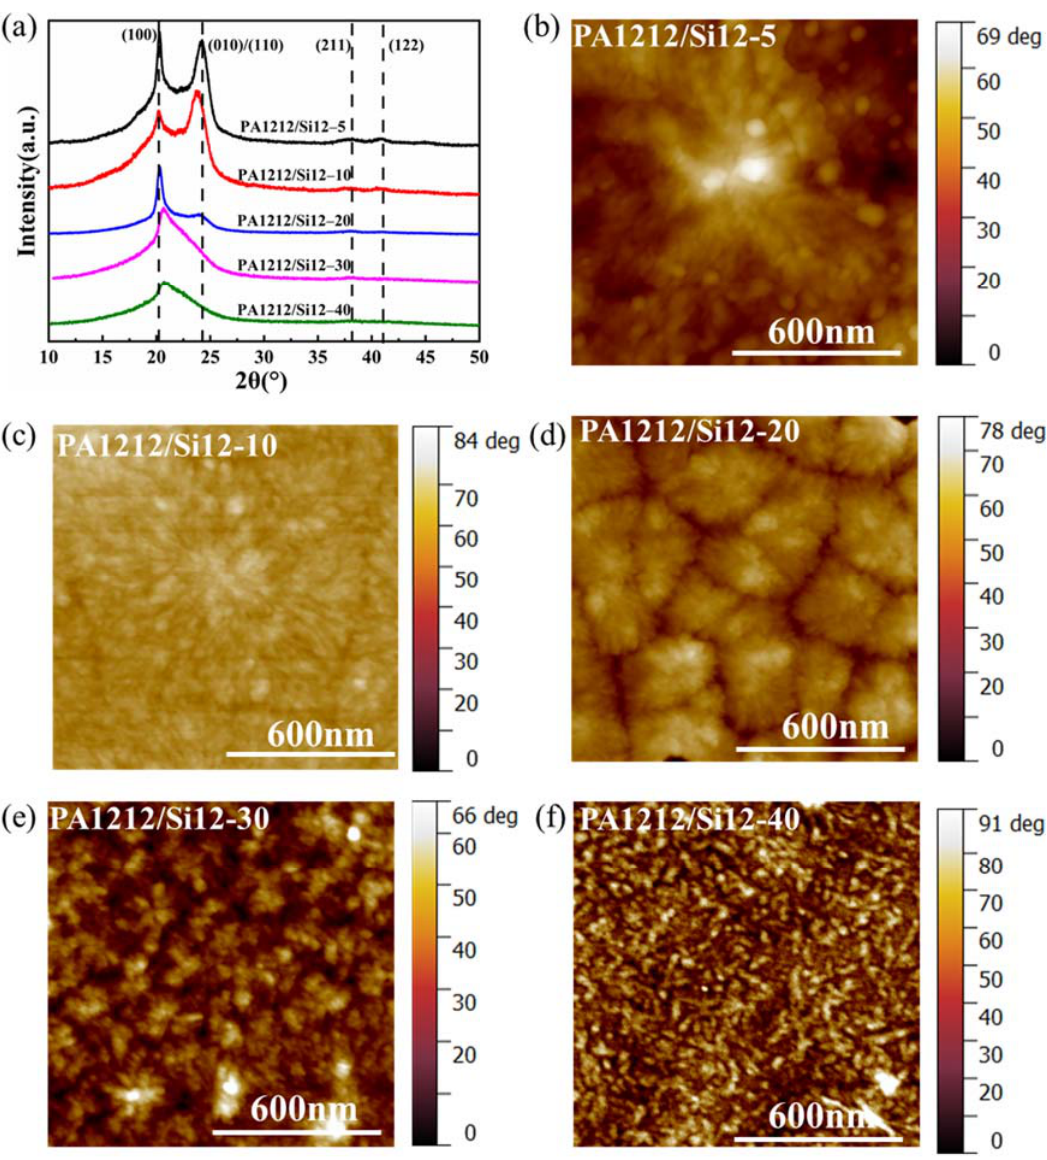
Figure 3. The WAXD patterns ( a ) and the AFM phase images ( b – f ) of PA1212/Si12 copolymers.